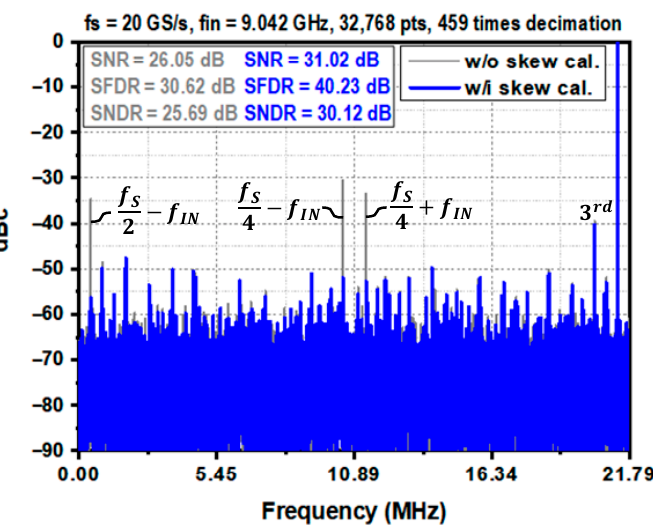
Figure 17. Measured FFT spectrum with and without skew calibration at 20 GS/s with a 9.085 GHz input.